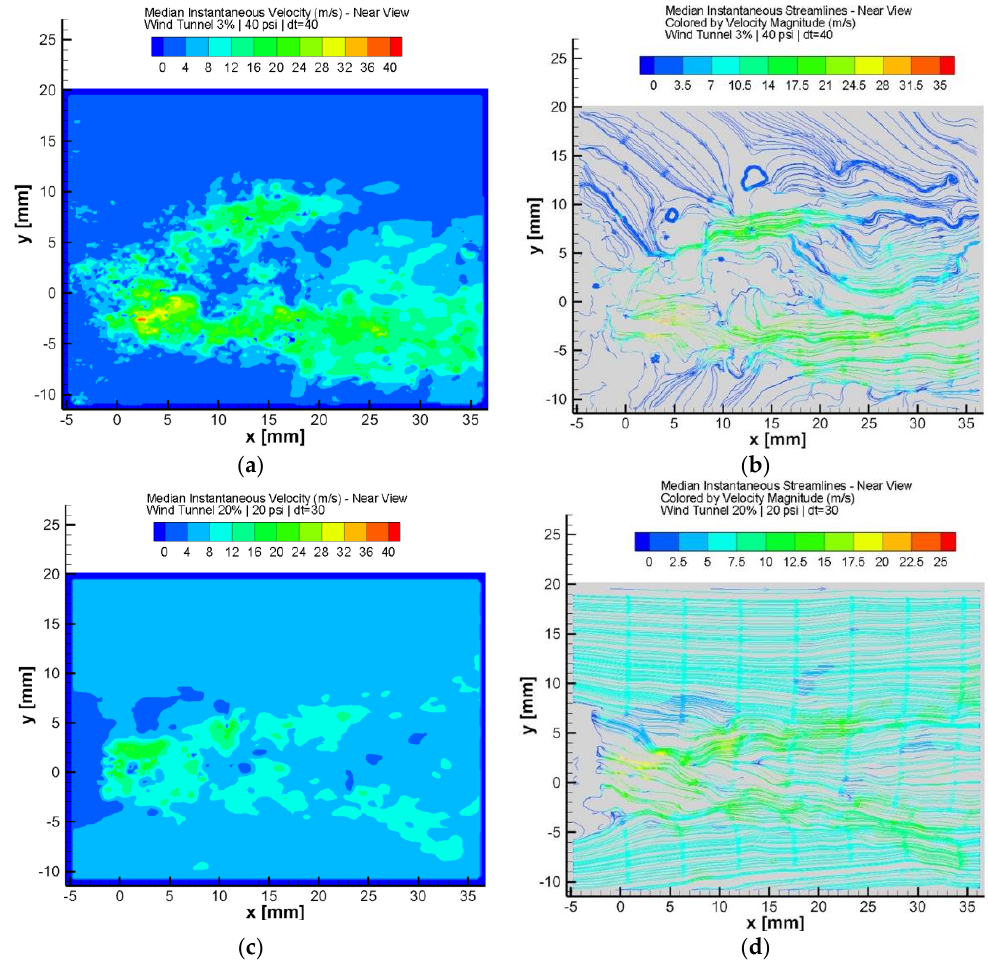
Figure 5. Instantaneous 2D near region velocity map ( a , c ) and their streamlines ( b , d ) for 40 psi, 3% freestream wind tunnel setting ( a , b ) and for 20 psi, 20% freestream wind tunnel setting ( c , d ).